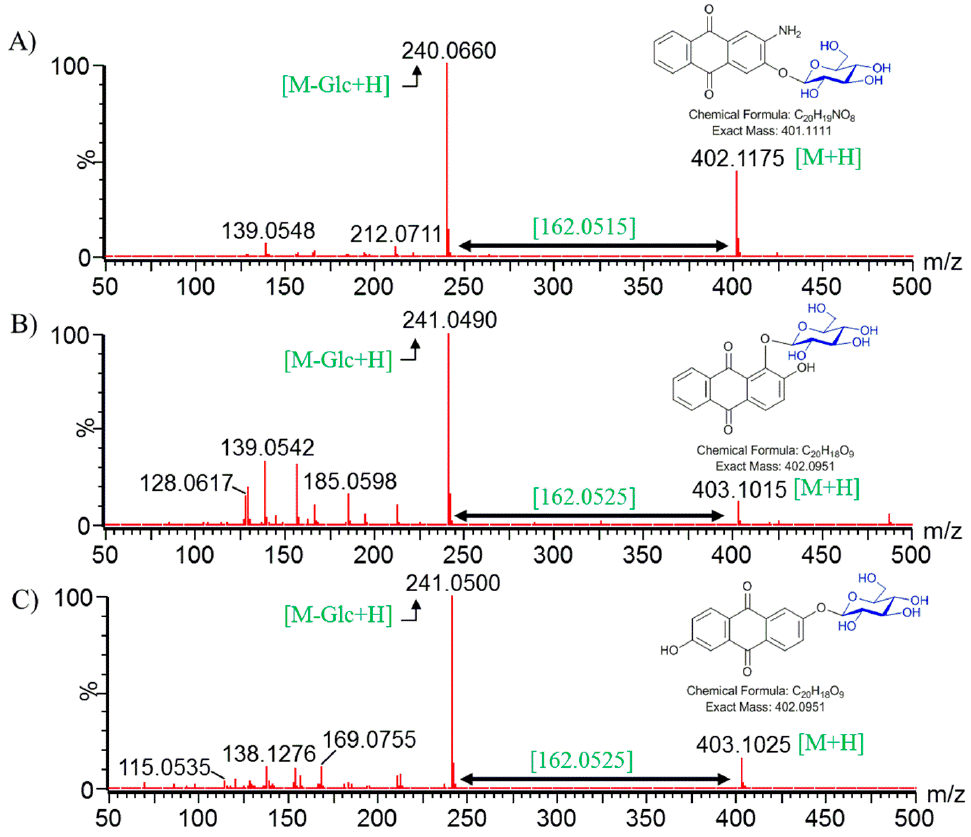
Figure 3. HQ-QTOF ESI/MS analyses of glycosylated ( A ) 2-amino-3-hydroxyanthraquinone; ( B ) Alizarin; and ( C ) anthraflavic acid confirmed by comparing the mass fragments.